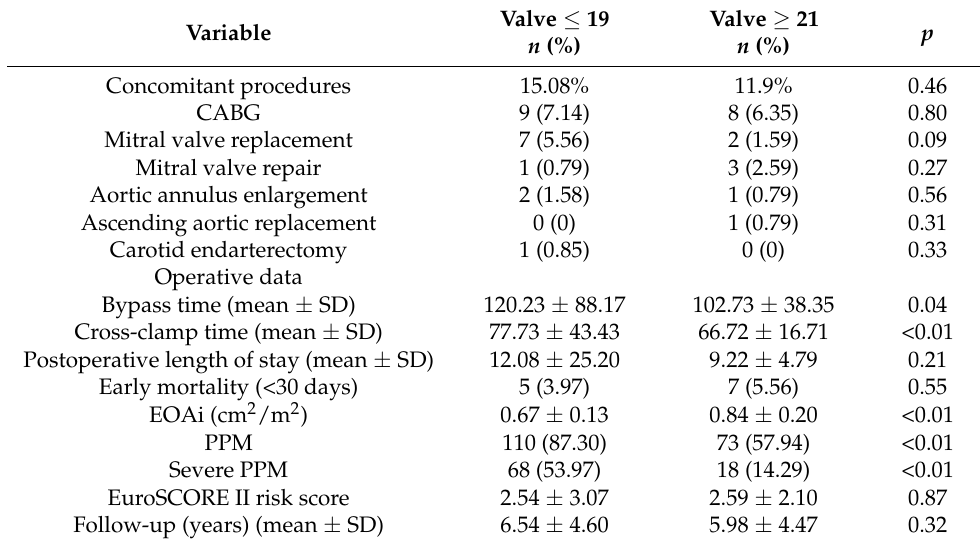
Table 3. Intraoperative data, in-hospital, and long-term outcomes of matched